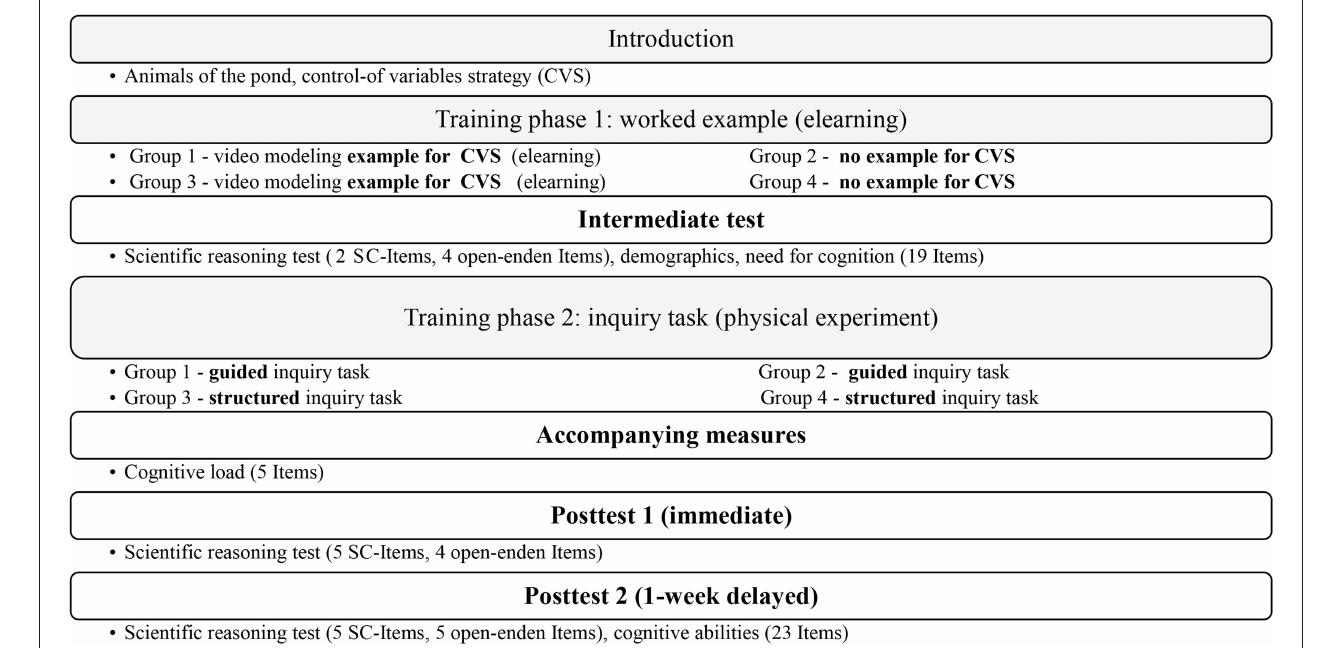
FIGURE 1 | Procedure with the four assessment time points (in bold) and the assessed